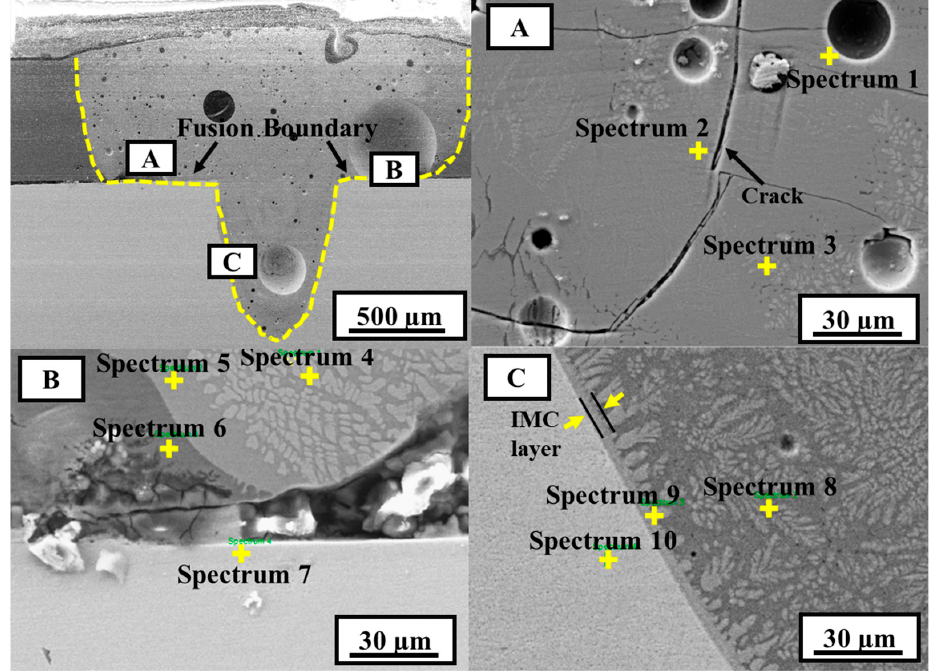
Figure 12. SEM images of sample C2 (power = 1700 W, welding speed = 20 mm/s); ( A , B , C ) are the magnified SEM images of microstructures at location A, B and C in weld fusion zone, respectively. Table 4. Chemical composition of zones denoted in Figure 12.